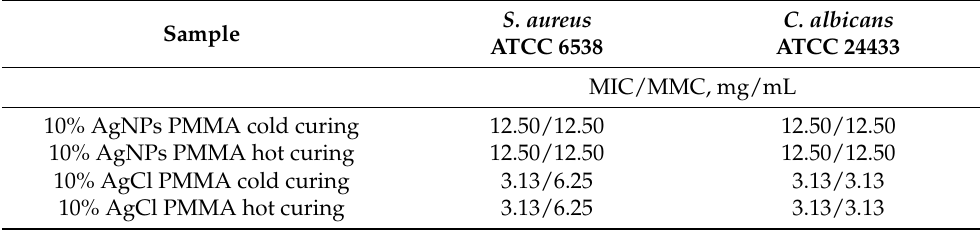
Table 2. Antimicrobial activity of samples against S. aureus and C. albicans strains tested by microdilu- tion method (MIC/MMC). Minimum inhibitory concentrations (MIC) and minimum microbicidal concentrations (MMC) were determined with three independent